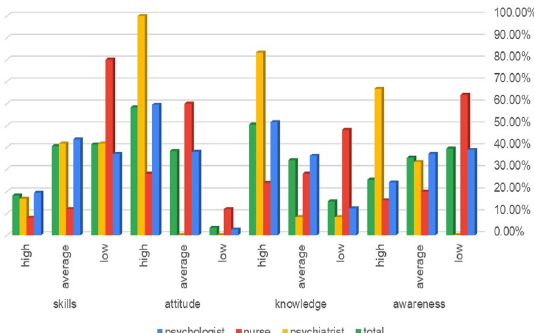
Fig. 1 Distribution of the studied variables among the studied sample ( n Fig. 2 Difference of the studied variables among the studied sample